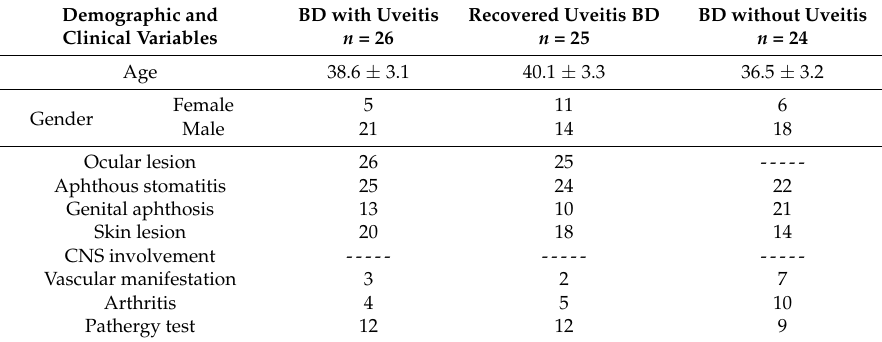
Table 1. Demographic and clinical conditions of enrolled cases.